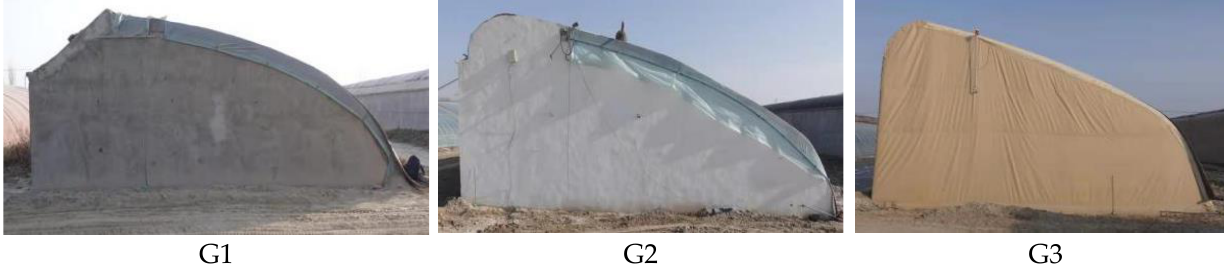
Figure 3. Three types of CSGs for test.